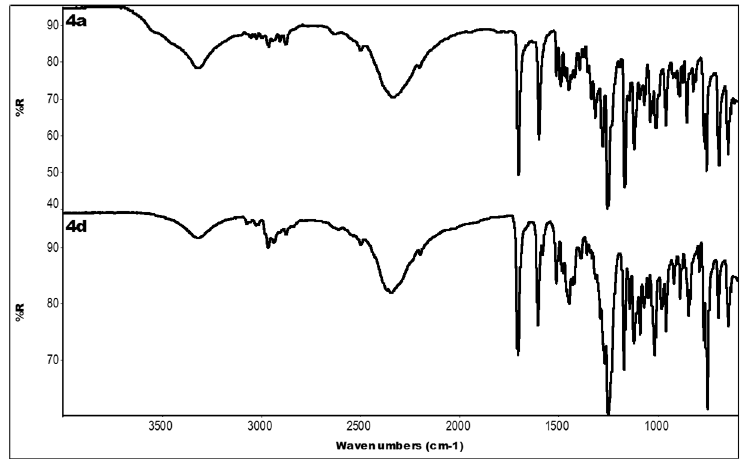
Figure 6. IR spectra of protonated compounds 4a (R = H) and 4d (R = 2-OCH 3 ).